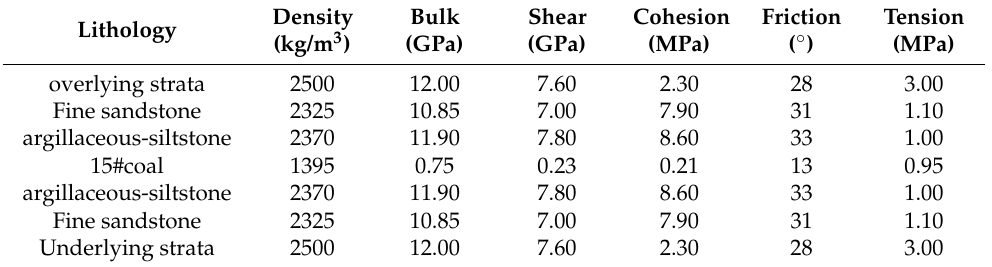
Table 1. Micro-parameters for the strata.